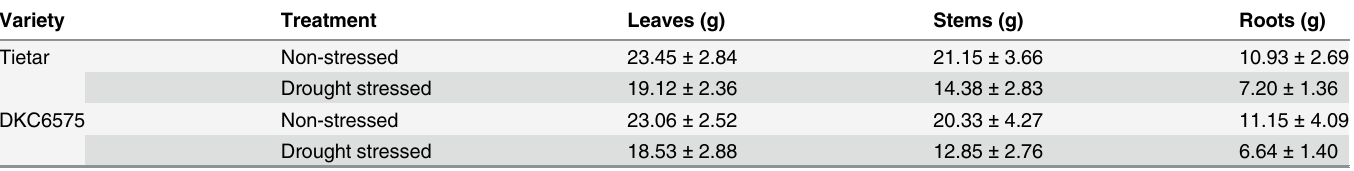
Table 5. Dry biomass (g) of leaves, stems, and roots, of control and drought stressed plants at the end of the drought treatment in the growth chamber experiment. Variety Treatment Leaves (g) Stems (g) Roots (g) Tietar Non-stressed 23.45 ± 2.84 Drought stressed DKC6575 Non-stressed Drought stressed Values represents mean ± Standard Deviation of n = 7 plants.